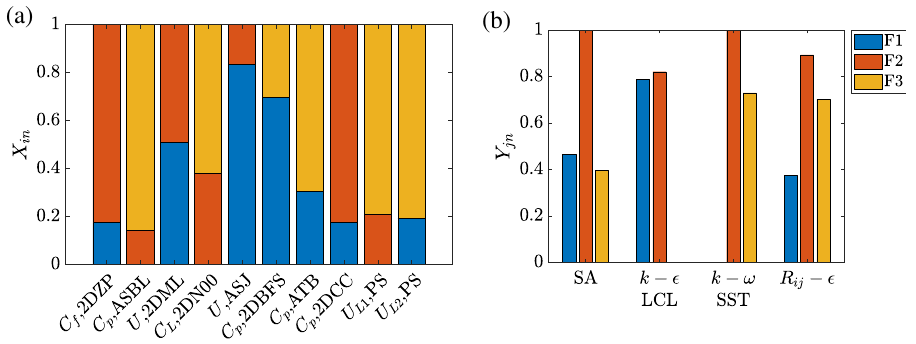
Figure 3. A visualization of ( a ) QoIs’ feature vectors and ( b ) models’ feature